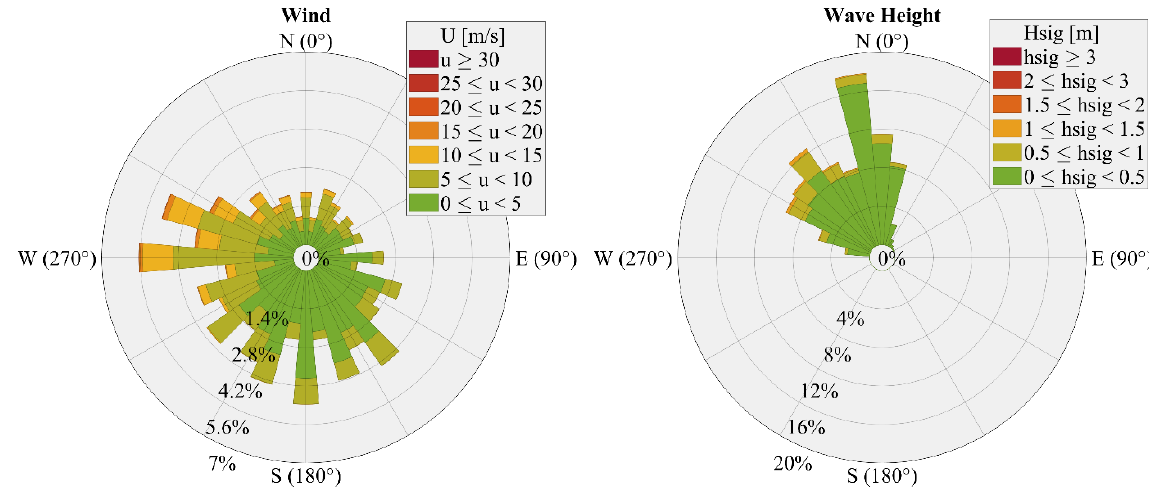
Figure 2. Directional distributions of wind speeds ( left ) and waves ( right ) in the study area Warne- münde.